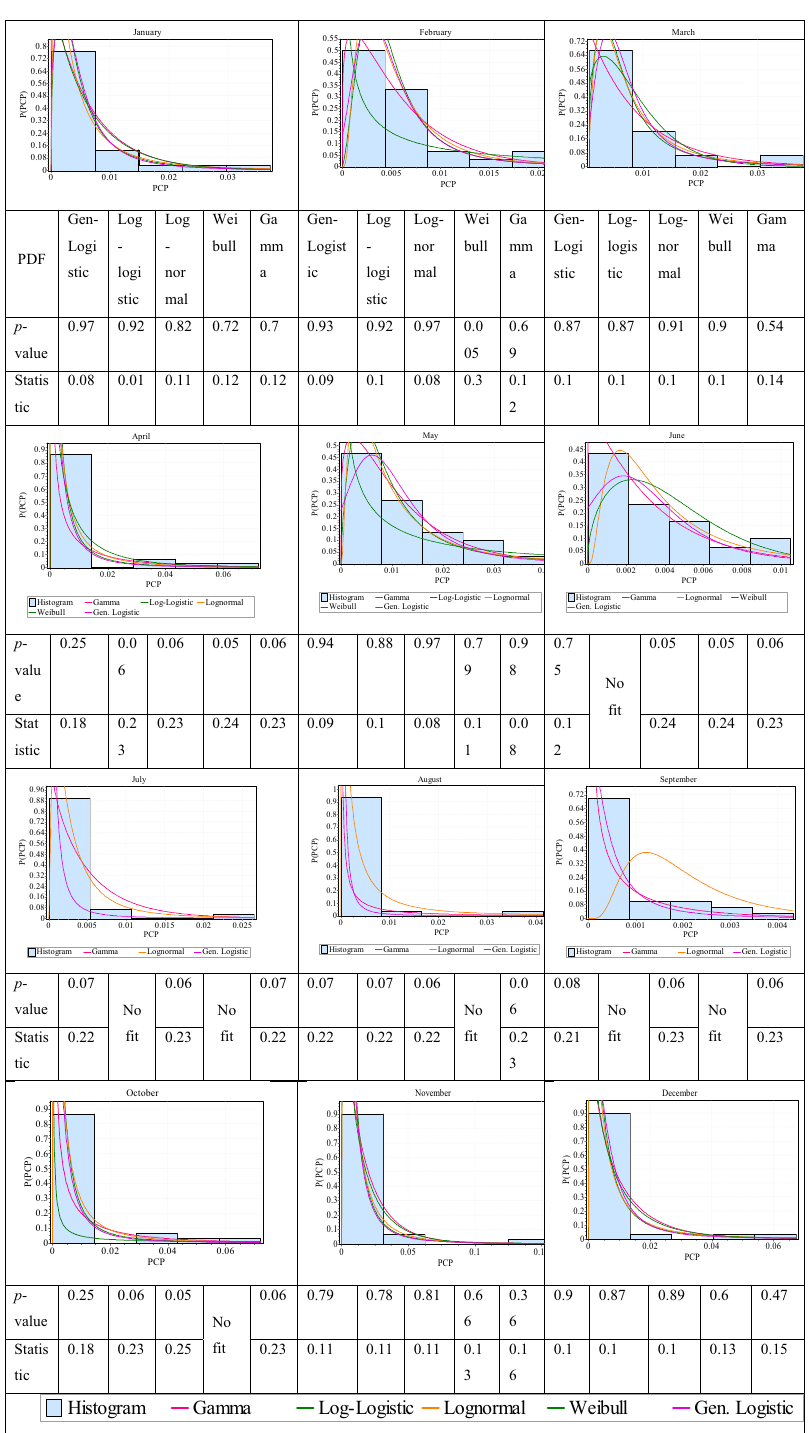
Figure 4. Different PDFs on the PCP values of various months for